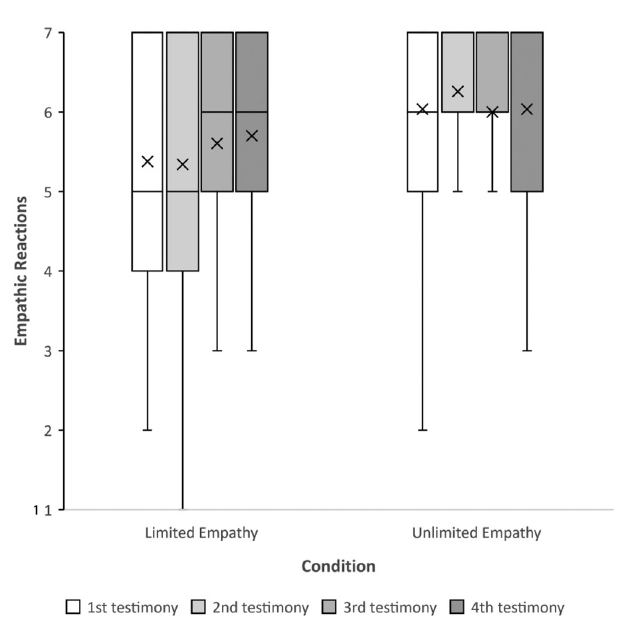
Fig.6|Empathicreactionstowardoutgrouptargets,asafunctionofcondition (i.e., limited empathy, n =53; and unlimited empathy, n =55) and order of empathy-inducing testimonies (i.e., 1 – 4). A signi fi cant main effect of the condi- tion on empathic reactions, F (1, 106)=6.34, p =0.013, d =0.49. The plot presents the maximum and minimum values as whiskers, the interquartile range as the vertical length of each box, the mean as the x marker, and the median as the horizontallinewithineachbox.Alltestsaretwo-tailed.Sourcedataareprovidedas a Source Data fi